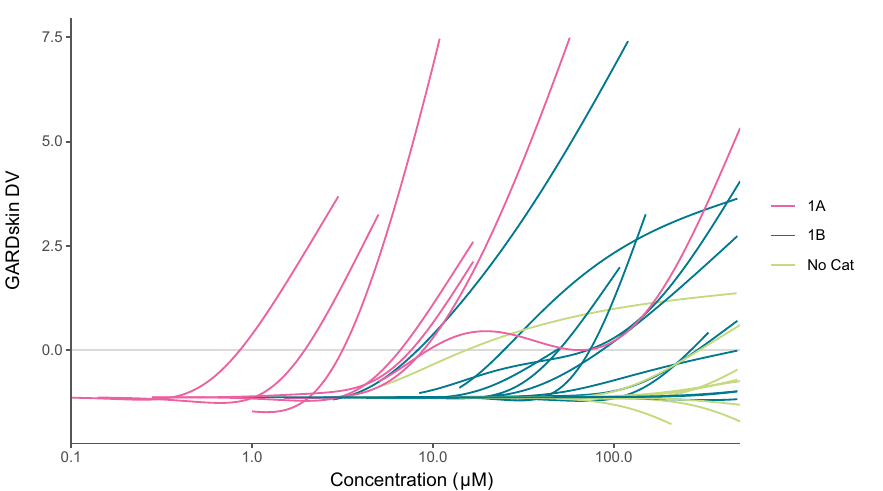
Figure 3. Visualization of acquired dose–response data. Each line represents a generalized additive model fitted to the dose–response data of a single chemical. The colors of the lines describe the GHS potency sub-categories, into which chemicals were assigned based on their LLNA results (1A: EC3 ≤ 2%; 1B: EC3 > 2%; No Cat: